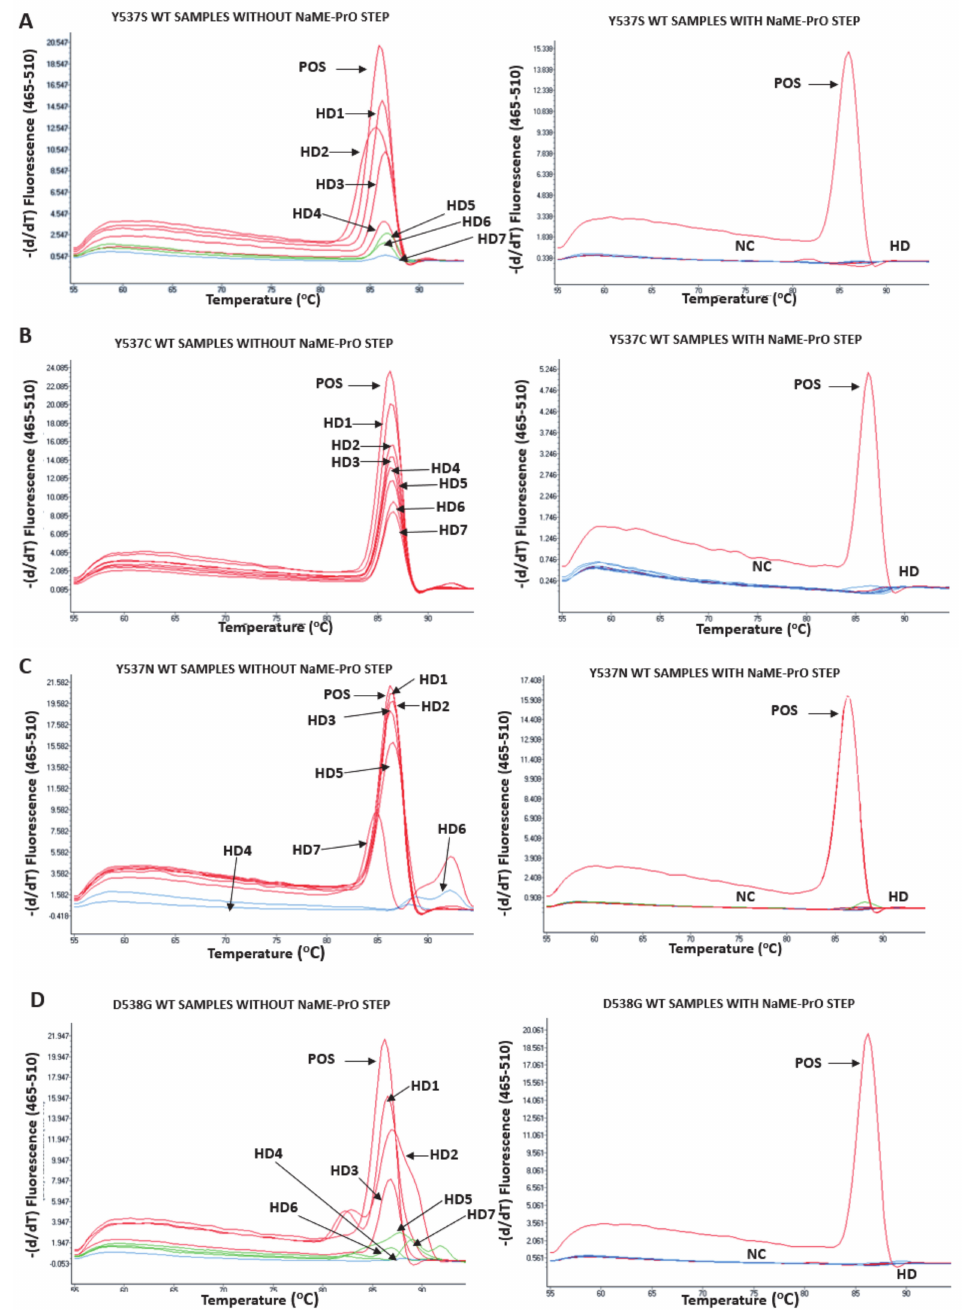
Figure 4. Diagnostic specificity of the ESR1 NAPA assay. Analysis of plasma-cfDNA samples from 7 healthy donors (HD) with and without NAME-PrO assay treatment prior to the ARMS-PCR. As a positive control (POS), we used synthetic oligonucleotide sequences harboring each of the four ESR1 mutations with WT gDNA (genomic DNA) at 9% mutation allele frequency. With the NAME-PrO assay treatment prior to the ARMS-PCR, none of the ESR1 mutations were detected in the HD plasma-cfDNA samples (red). NC: PCR negative control (blue). ( A ) Y537S mutation, WT samples without NAME-PrO step, and with NAME-PrO step, ( B ) Y537C mutation, WT samples without NAME-PrO step, and with NAME-PrO step, ( C ) Y537N mutation, WT samples without NAME-PrO step, and with NAME-PrO step, ( D ) D538G mutation, WT samples without NAME-PrO step, and with NAME-PrO